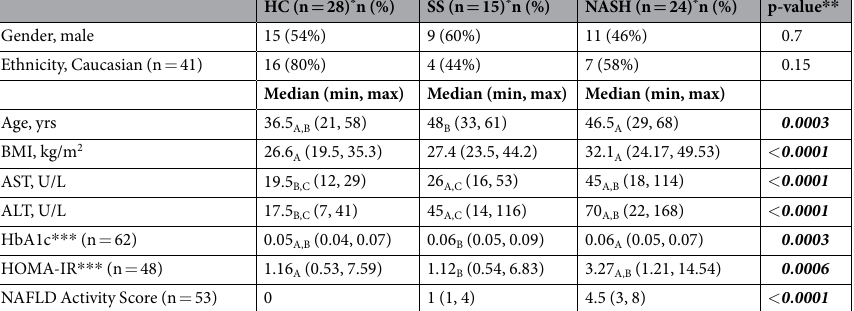
Table 1. Characteristics of patients included in the study. * For some variables numbers were lower due to missing values/exclusions. ** Kruskal Wallis test or Chi-square test as appropriate. *** Patients on diabetes drugs excluded. Same subscript letters denotes significant differences. HC: healthy controls, SS: simple steatosis, NASH: nonalcoholic steatohepatitis, AST: aspartate transaminase, ALT: alanine transaminase, HbA1c: Hemoglobin A1c, HOMA-IR: homeostasis model assessment estimated insulin